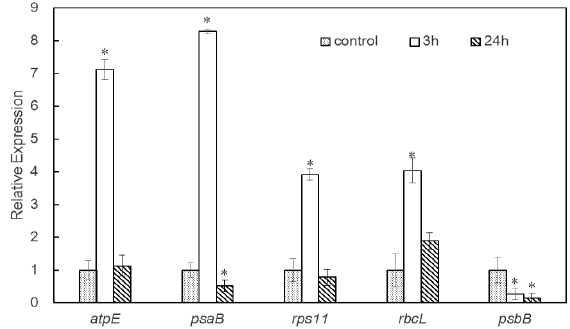
Figure 5. Analysis of transcript levels of the DAPs between salt stress and control conditions by quantitative real-time polymerase chain reaction (qRT-PCR). mRNA expression values were rescaled relative to the control. Statistical significant between experimental and control groups marked with asterisks: (*) p -value < 0.05.